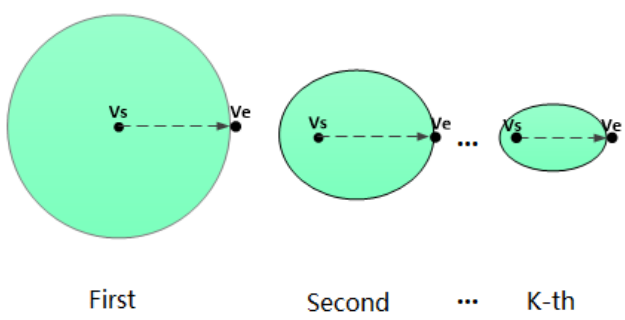
Figure 2. Search space of the ant colony algorithm.